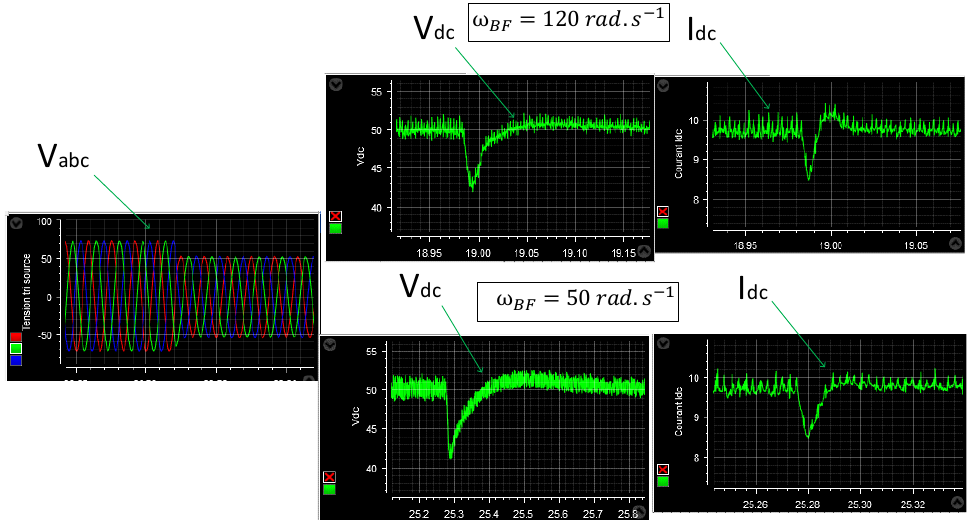
Figure 22. Experimental results (Test III (Table 2)) when the grid voltage is reduced from 55 V to 40 V with ω BF = 120 rad · s − 1 ( top ) and ω BF = 50 rad · s − 1 ( bottom